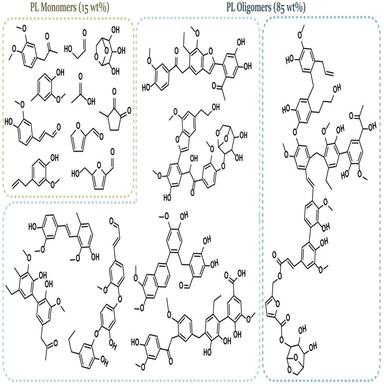
PL (identified) monomers and proposed (smaller and larger) oligomeric structures.